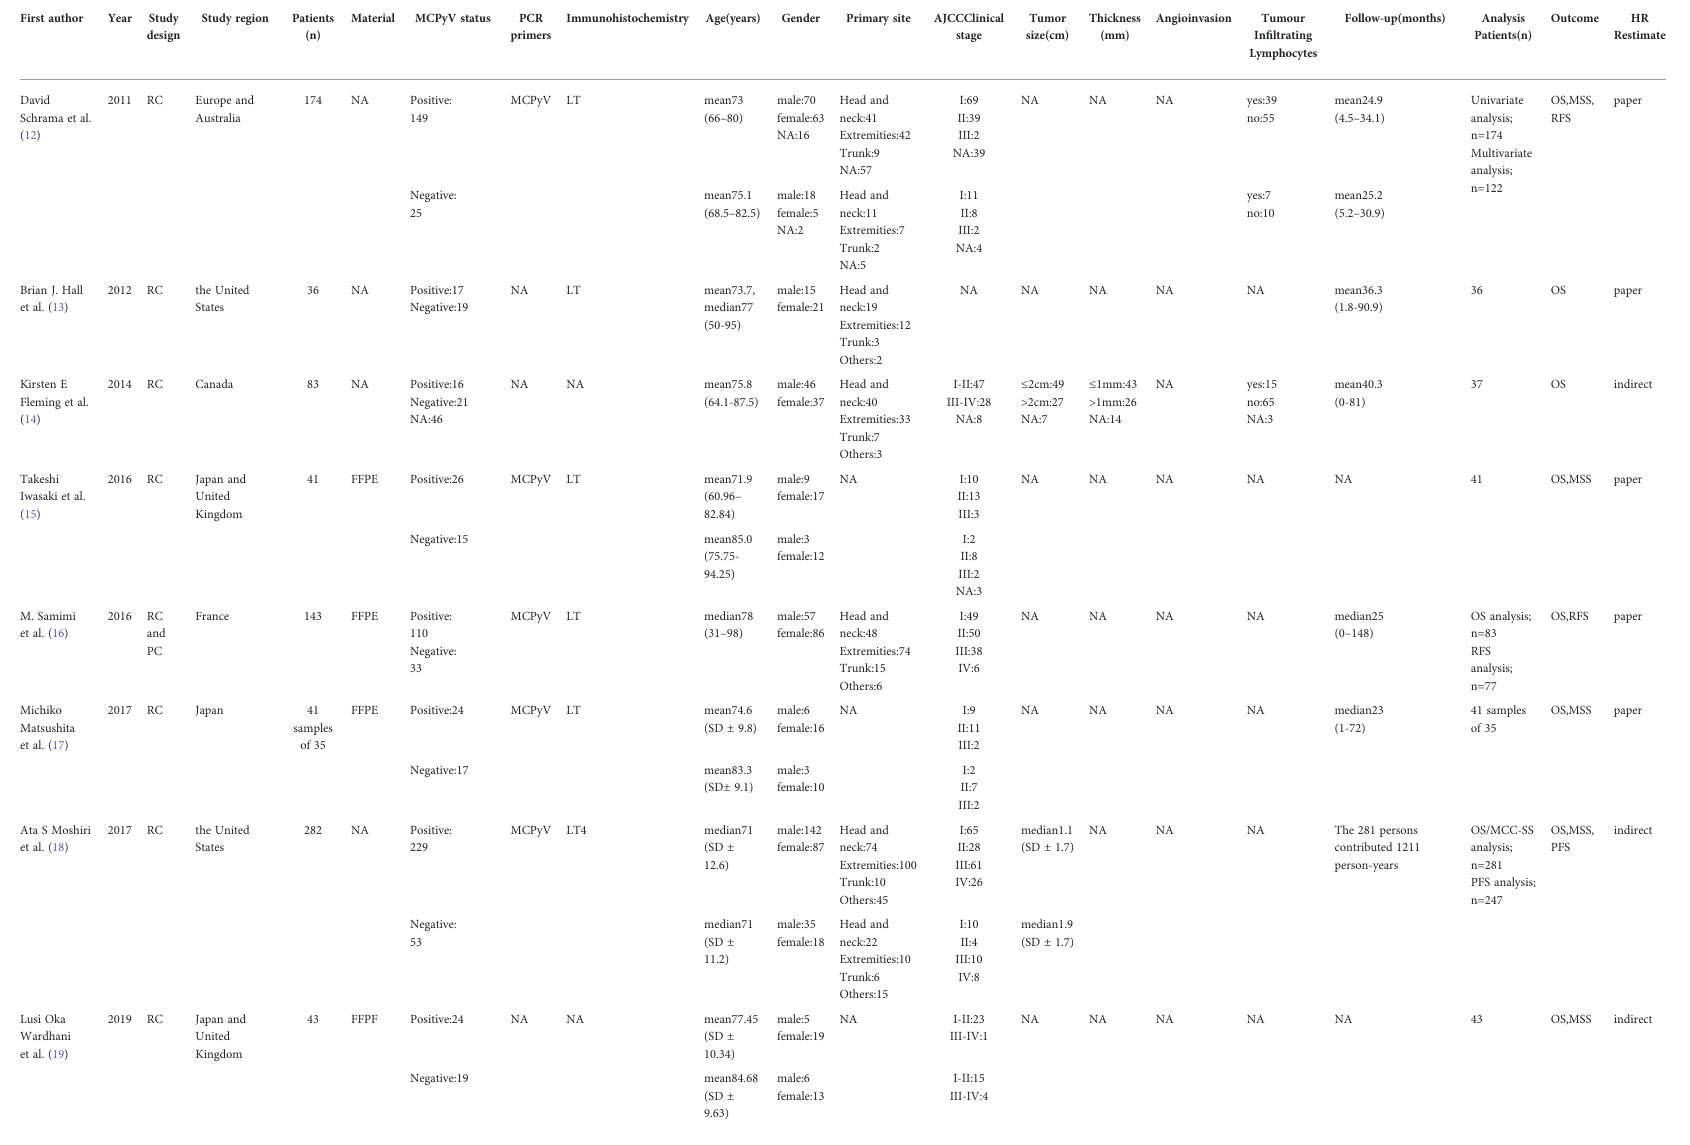
TABLE 1 Main characteristics of included studies. First author Year Study Study region Patients design